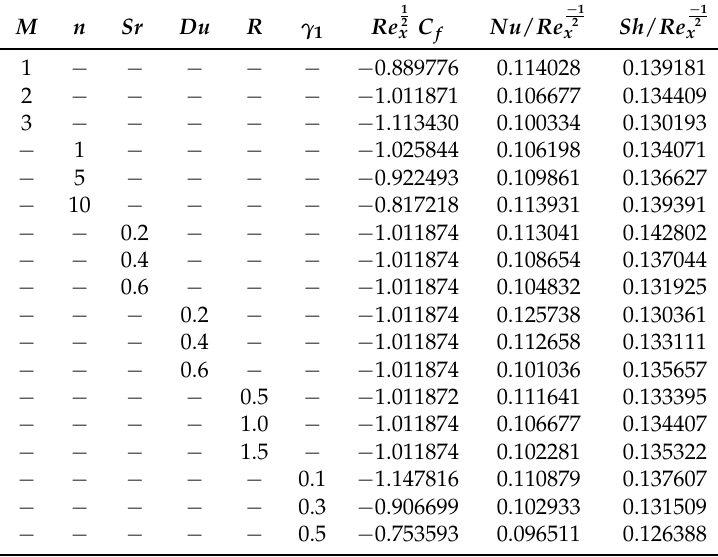
Table 5. C f , Nu x , and Sh x for the blowing